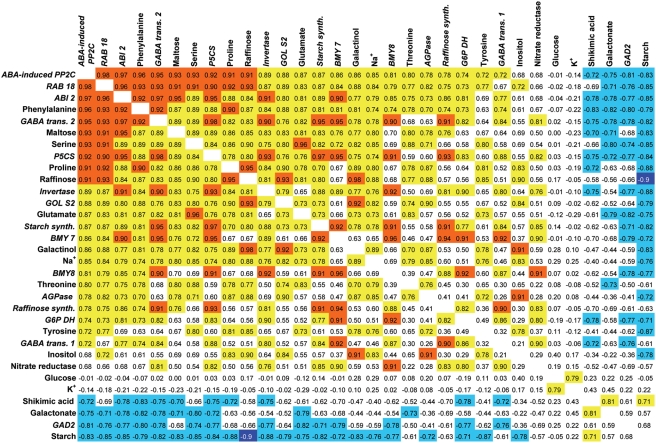
Correlation matrix of high salinity-induced metabolic and transcriptional changes.Pearson correlation coefficients of a pairwise correlation analysis of changes in metabolite levels and gene expression from all timepoints of two independent salt stress experiments. The background colours mark the value of the coefficient: orange: >0.91; yellow: >0.7; blue: <−0.7. Pearson correlation coefficients >0.91 and <−0.91 are significant (P-value <0.05) and correlation coefficients >0.7 and <−0.7 are suggested to be biologically relevant.